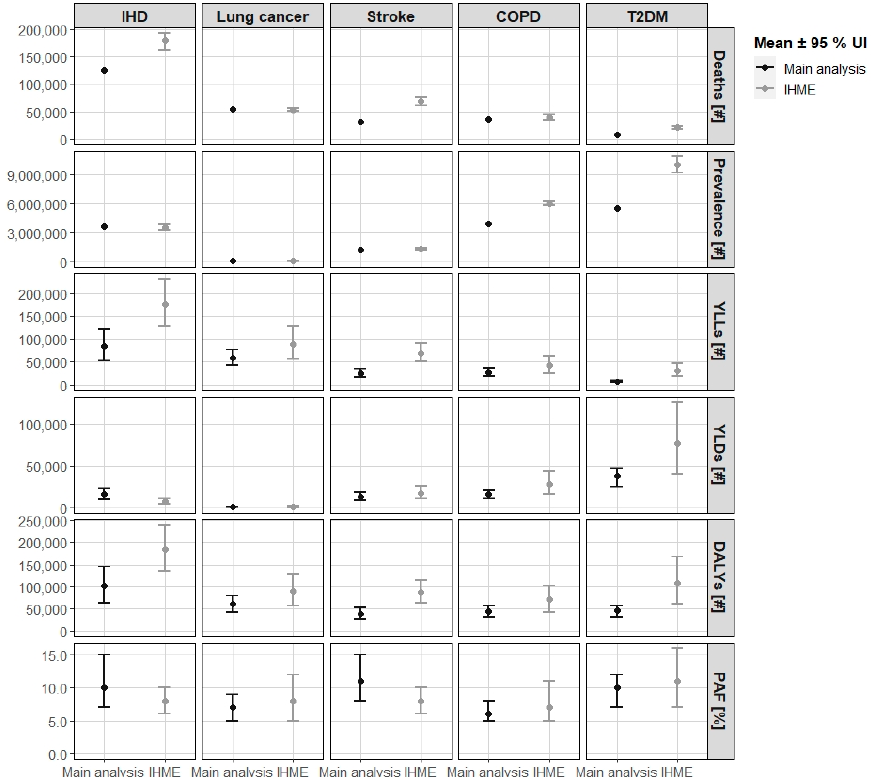
Figure 4. Comparison of the main analysis with IHME’s GBD-2019 study estimates for the year 2018. PAF = population attributable fraction. YLLs = years of life lost due to mortality. YLDs = years lived with disability. DALYs = disability-adjusted life years. UI = uncertainty interval. COPD = chronic obstructive lung disease. GBD = global burden of disease. IHD = ischemic heart disease. IHME = Institute for Health Metrics and Evaluation. T2DM = type 2 diabetes mellitus.